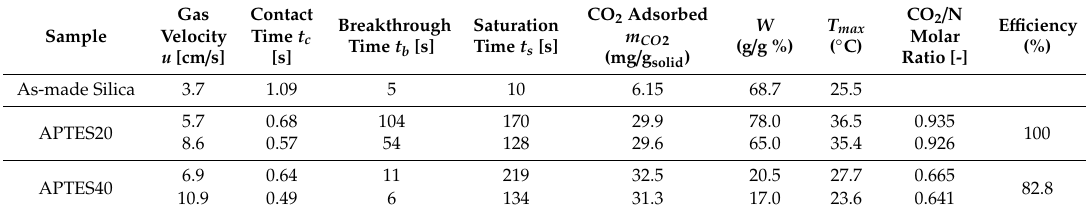
Table 4. Adsorption test data for both amino-functionalized samples at various fluidization velocities.